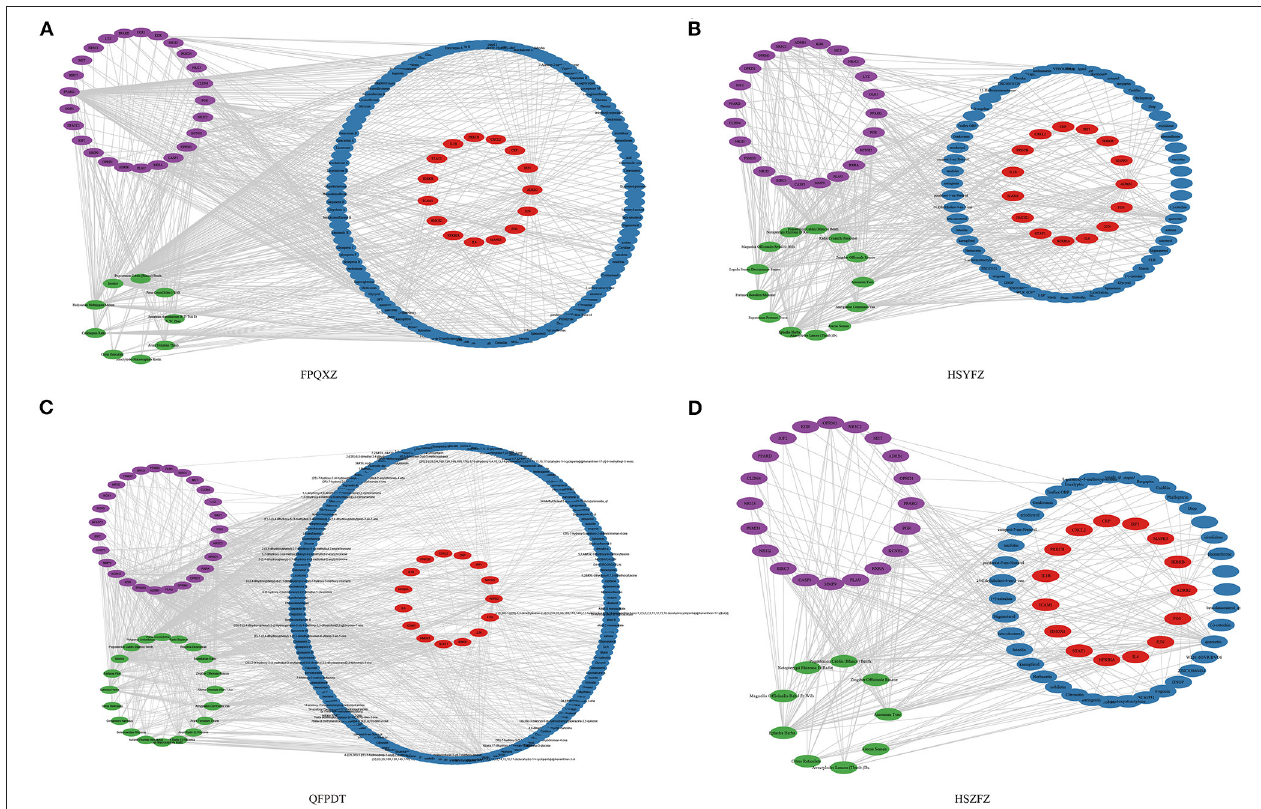
FIGURE 3 | The Chinese medicine herb- constituent -immune target network. (A) FPQXZ’s Chinese medicine herb—constituent -immune target regulatory network. (B) HSYFZ’s Chinese medicine herb—constituent -immune target network. (C) QFPDT’s Chinese medicine herb—constituent -immune target network. (D) Chinese medicine herb—constituent -immune target interaction network of HSZFZ.